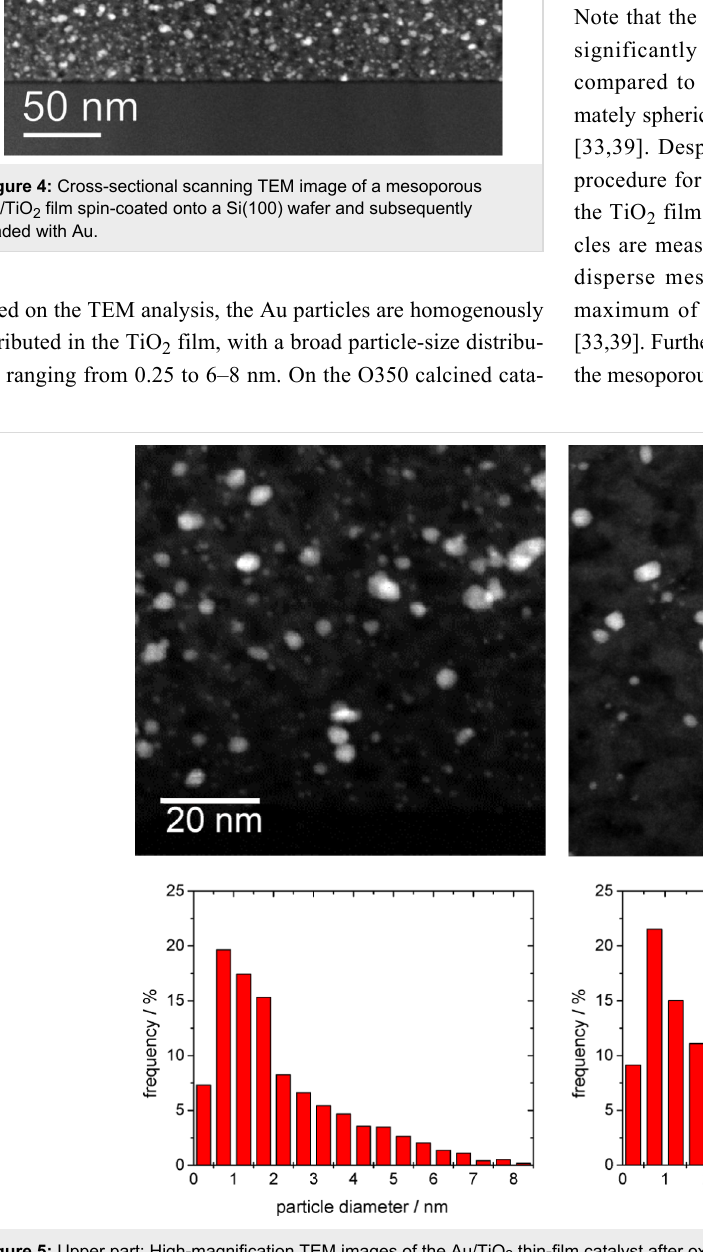
Figure 5: Upper part: High-magnification TEM images of the Au/TiO 2 thin-film catalyst after oxidative pretreatment (left) and after subsequent CO oxi- dation reaction (300 min on stream, right); lower part: Corresponding Au particle-size distribution.